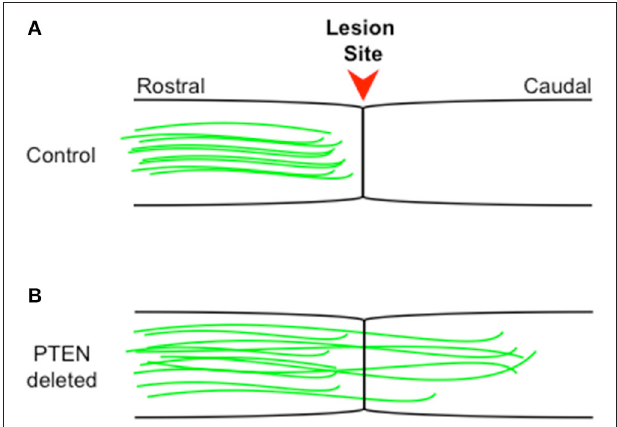
FIGURE 1 | Corticospinal tract regeneration proceeds in the absence of PTEN. Schematic representation of sagittal spinal cord sections from control wild type (A) and PTEN deleted (B) mice. Intact corticospinal tract neurons (green) rarely regenerate beyond the injury site (arrowhead) into more caudal regions, while in PTEN deleted (B) mice, intact corticospinal tract neurons (green) consistently regenerate well beyond the injury site into more caudal regions even 1 year following the initial injury. The figure is based on primary data presented previously (Liu et al., 2010; Du et al.,